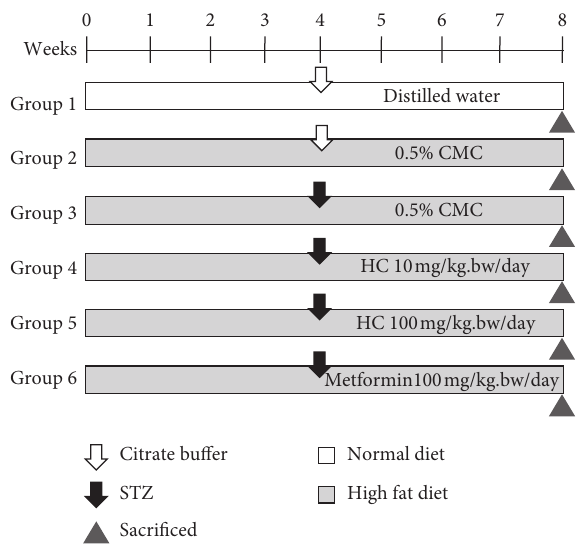
Figure 1: Experimental protocols of HFD-STZ-induced diabetic rat model. Each group contain 6 rats. CMC, carboxymethylcel- lulose; HC, the suspension of fermented H. cordata .